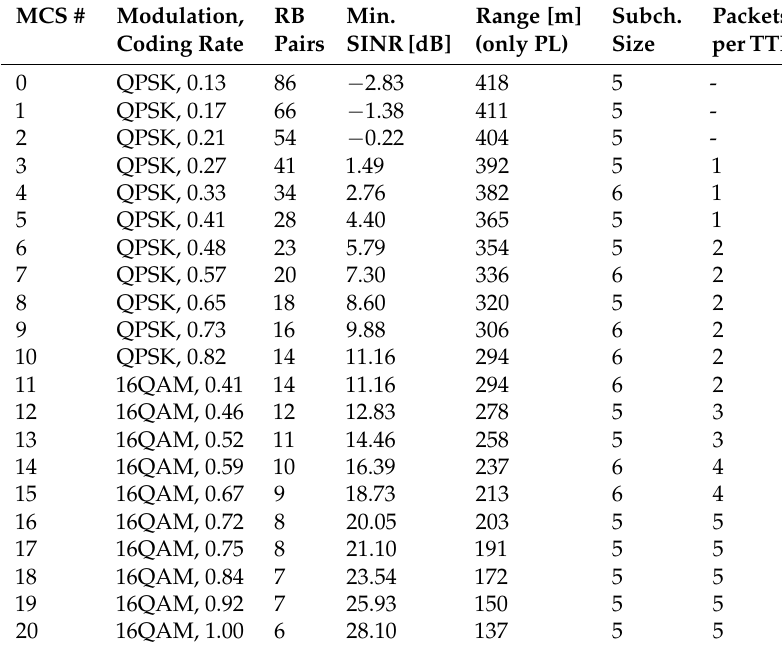
Table 3. LTE-V2X modulation and coding schemes and corresponding